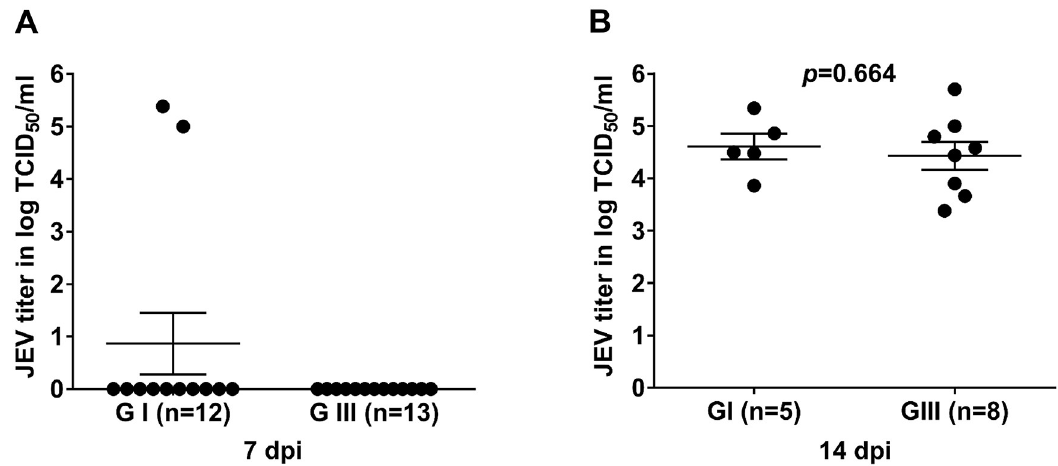
Fig 3. Viral titers in salivary glands of JEV-infected mosquitoes. Cx . pipiens mosquitoes were orally infected with GI or GIII viruses and salivary glands of the infected mosquitoes were collected at 7 dpi (A) and 14 dpi (B) for measurement of JEV titers by TCID 50 assay on BHK-21 cells. n , the numbers of mosquitoes tested positive for JEV in midguts. The p values were generated by Student t -test between GI- and GIII-infected groups. A p value of < 0.05 was considered significant.